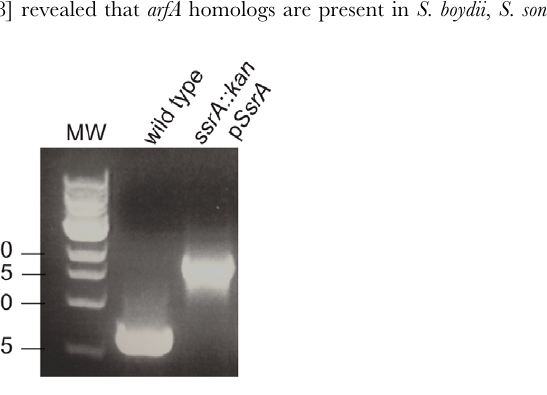
Figure 1. ssrA is dispensible in S.flexneri when a second copy of the gene is provided. Diagnostic PCR reactions were used to verify deletion of ssrA in S. flexneri ssrA::kan pSsrA . The expected product size for wild-type ssrA is 0.6 kb and for ssrA::kan is 1.7 kb. A control reaction using genomic DNA from wild-type S. flexneri and molecular weight markers with sizes in kb are indicated.